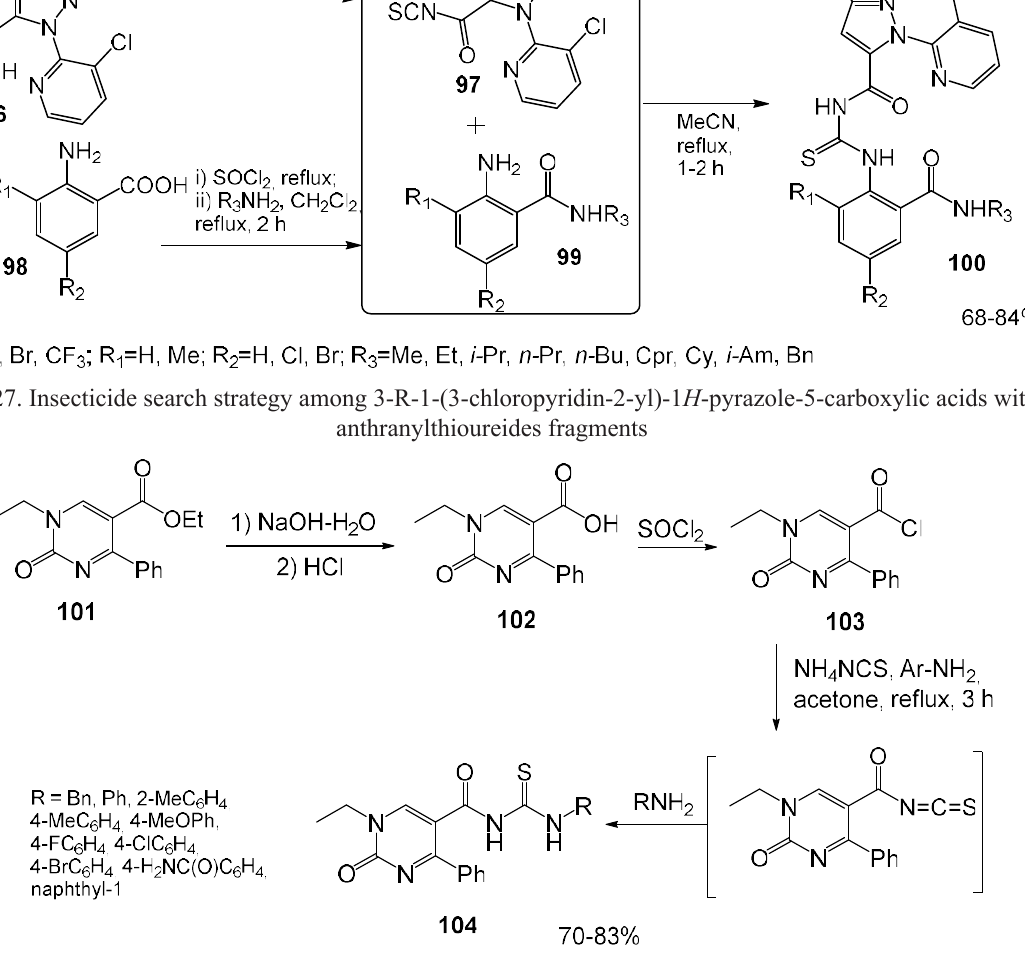
Fig. 28. Antitumor strategy among 1-ethyl-2-oxo-4-phenyl- N